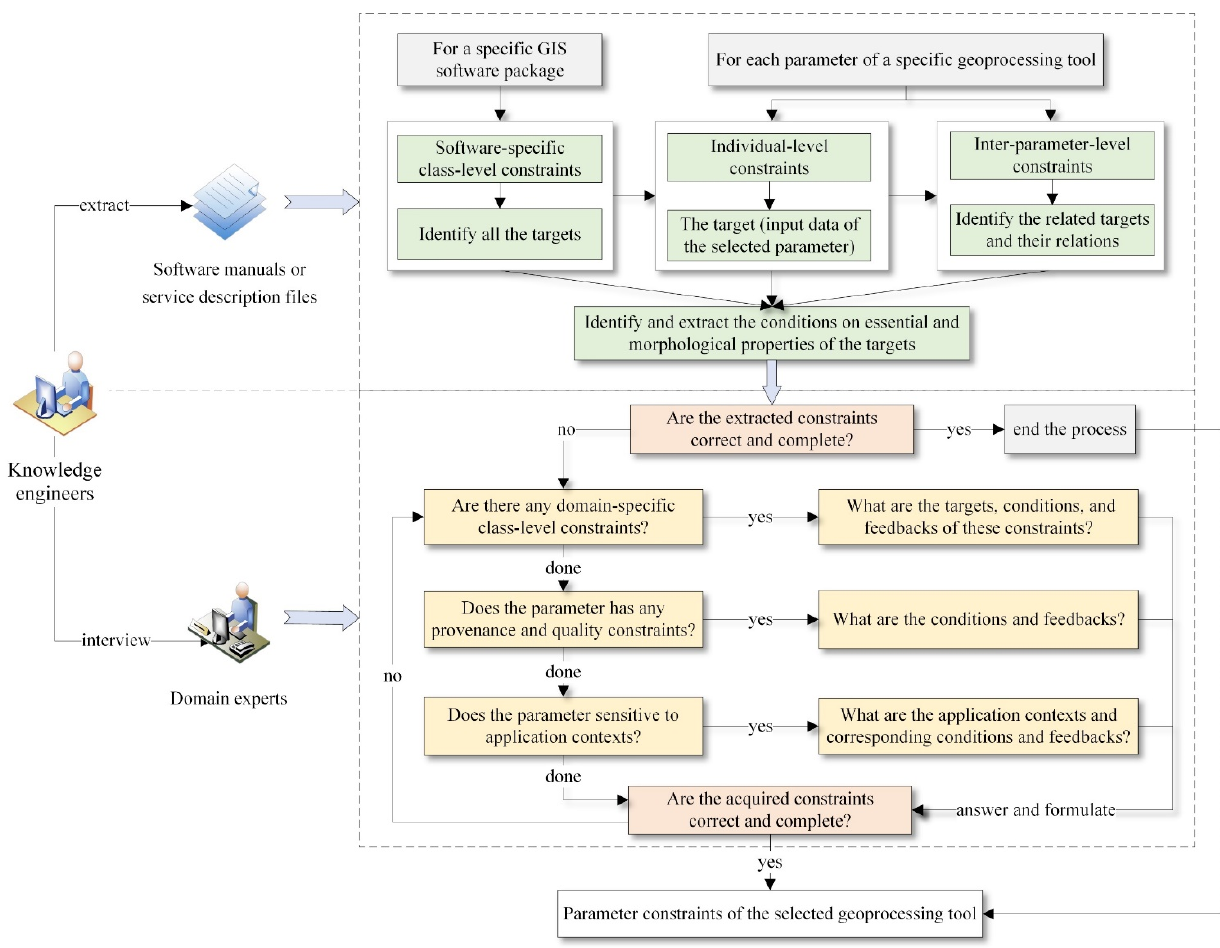
Figure 5. A two-phase process to identify and extract parameter